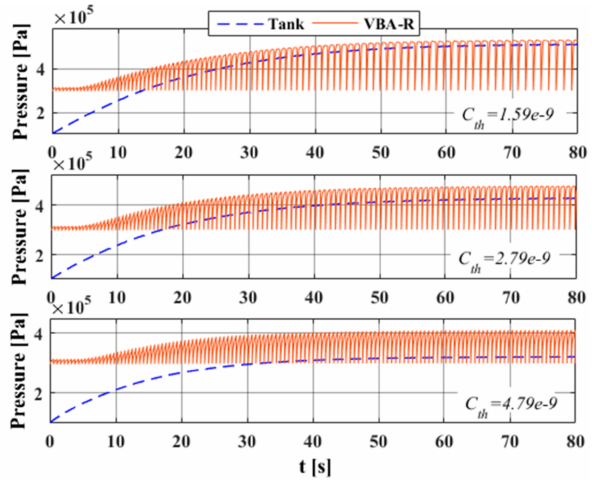
Figure 12. Pressure response with different